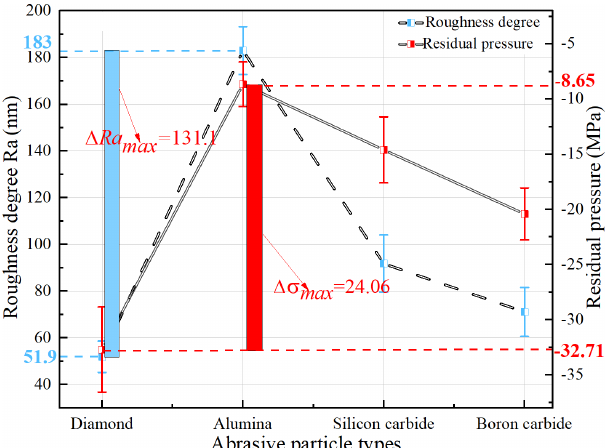
Figure 9. Relationship between types of abrasive grains and surface roughness and residual stress.